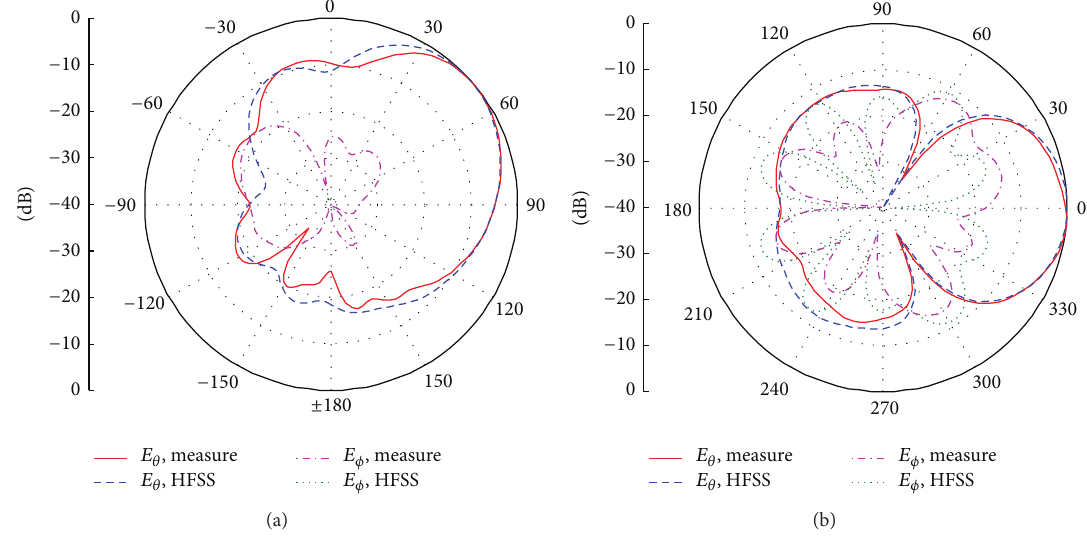
Figure 4: Elevation (a) and azimuth (b) radiation patterns for the Yagi array (Figure 2) working at 5.1 GHz.